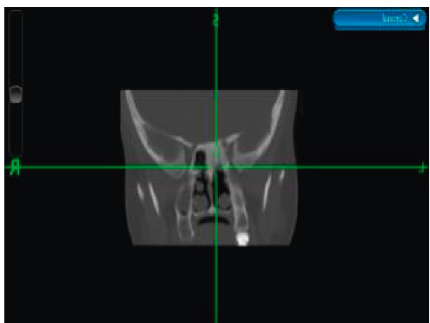
Figure 7: Imaged-guided nasal endoscopy shows a left sphenoid sinus lesion.